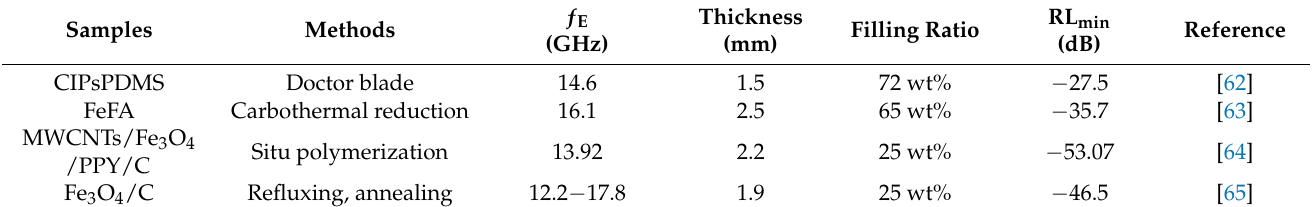
Table 4. The electromagnetic absorption performance of blended Fe-based composites.